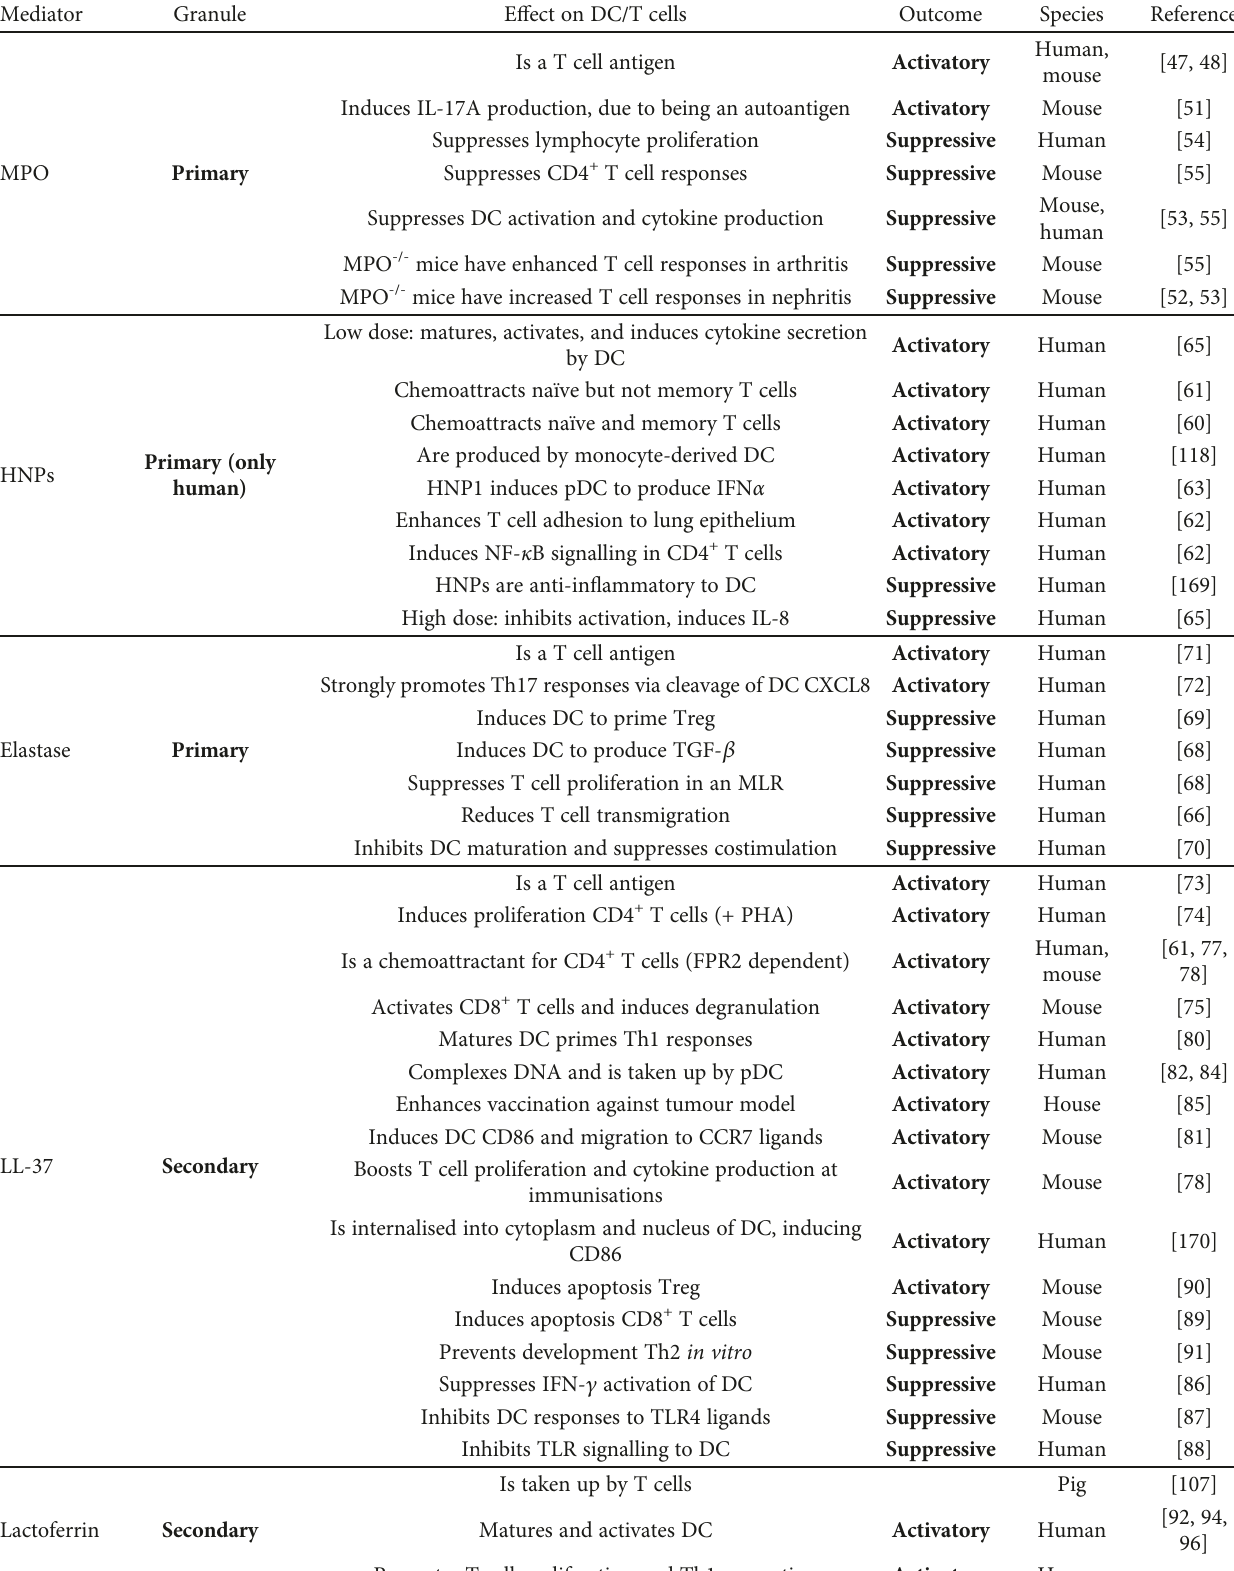
Table 1: Abundant contents of neutrophil granules and their impact on T cell